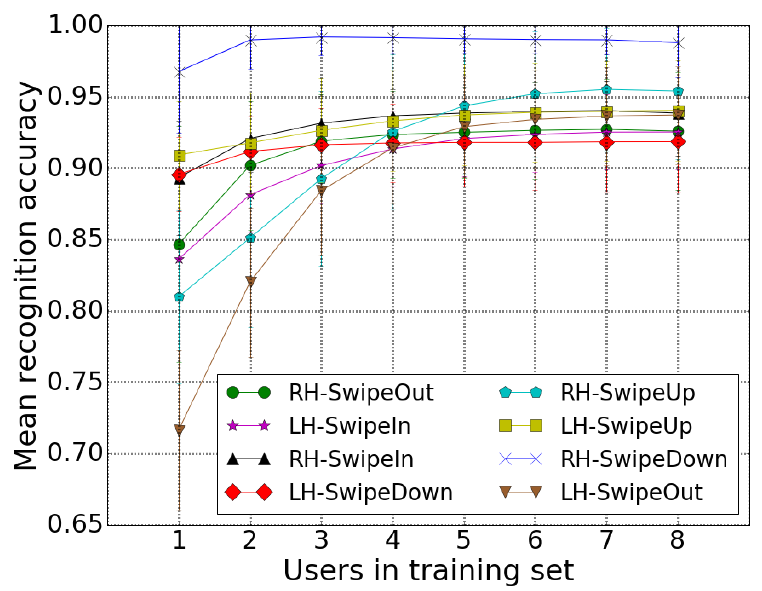
Figure 6. Mean accuracy per gesture vs. number of users in training set, without the mischievous user.